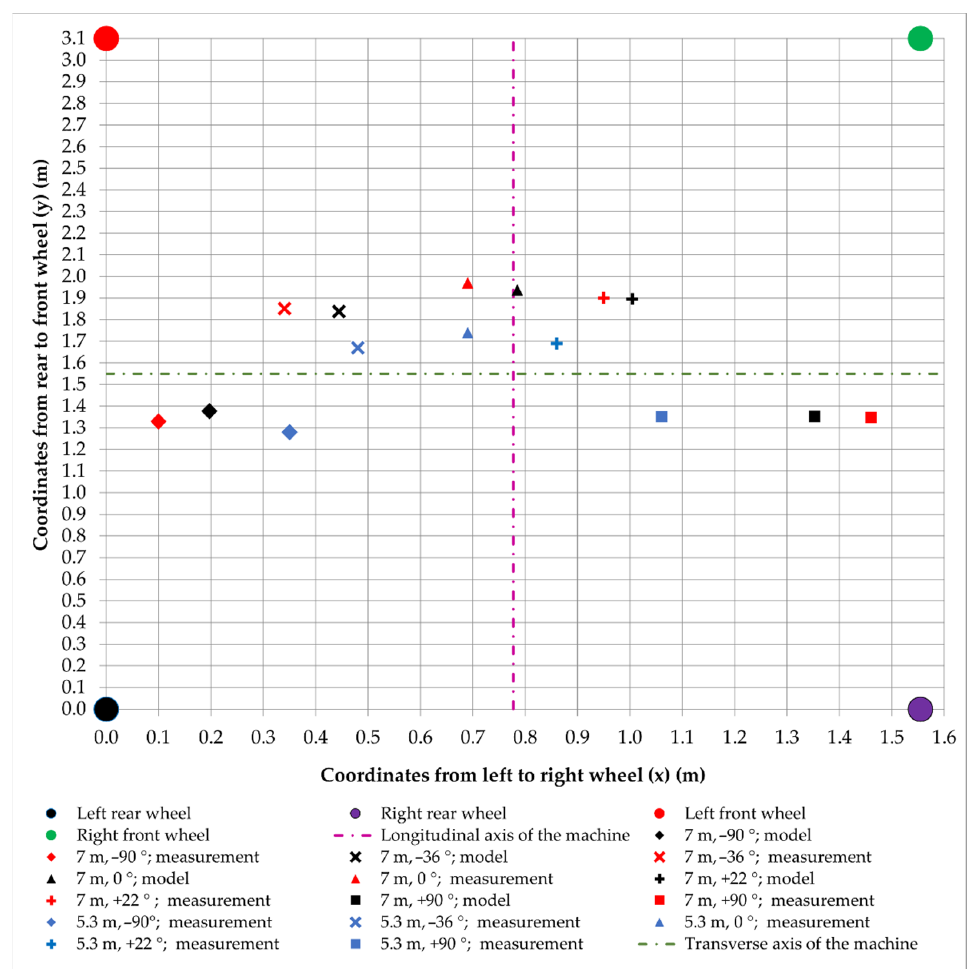
Figure 6. Center of gravity—Position 2.